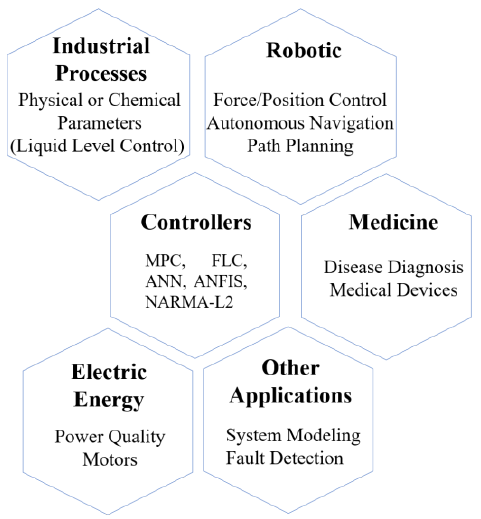
Figure 1. Applications of MPC, FLC, ANN, ANFIS and NARMA-L2 controllers.